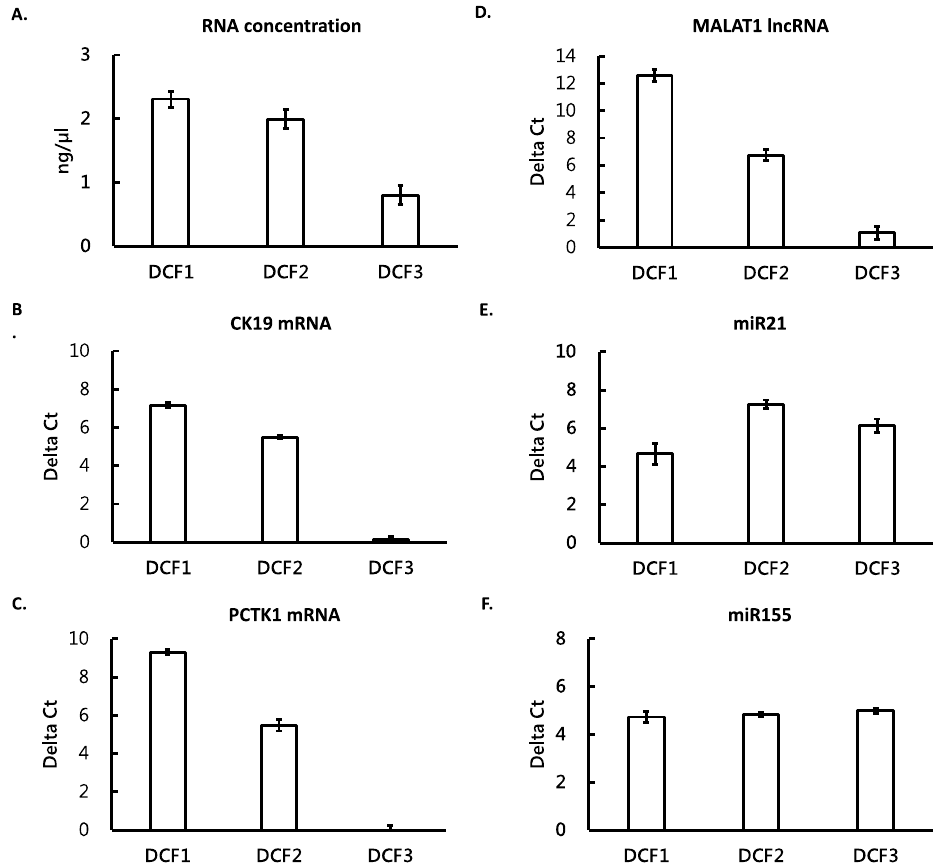
Figure 2. RNA contents in different DC fractions of EVs from medium with living cells. DCF1, DCF2, and DCF3 were three fractions of the media derived from two-step centrifugation, as described in Materials and Methods. RNA was purified from the fractions and its concentration was determined by a Qubit fluorometer ( A ). The levels of different RNA species were measured by RT-qPCR. These RNA species included mRNAs of CK19 and PCTK1 ( B , C , respectively), lncRNA of MALAT1 ( D ), and miRNAs of miR21 and miR155 ( E , F , respectively). All the measurements were performed in triplicate and the bars are shown as mean ± standard error.